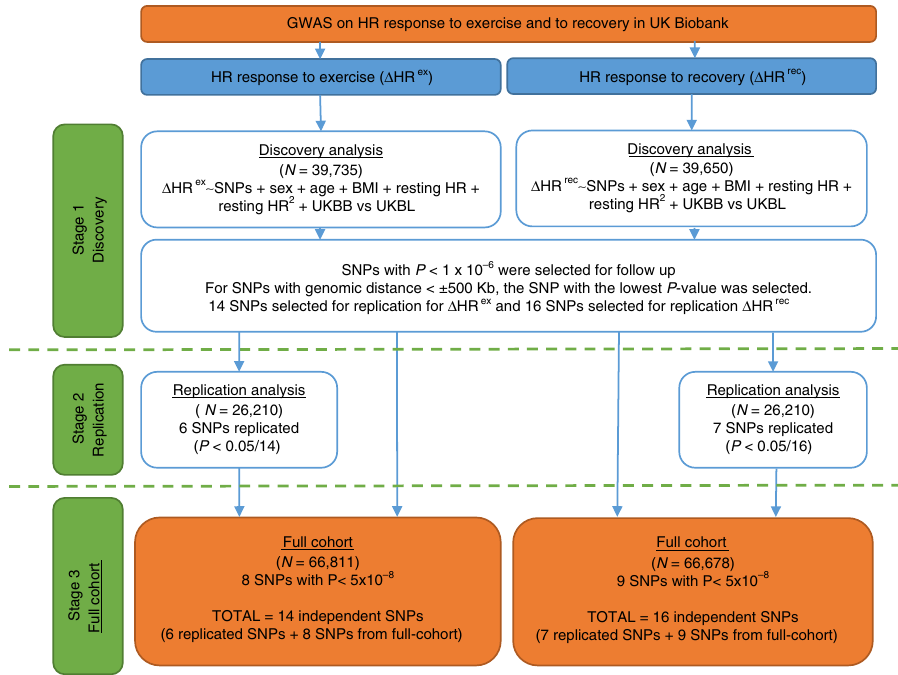
Fig. 1 Flowchart of the analytical 3-stage approach. HR heart rate, Δ HR ex changes in HR during exercise, Δ HR rec changes in HR 1 min post-exercise, SNP: single-nucleotide polymorphism, BMI: body mass index, UKBB: UK Biobank genetic array, UKBL: UK BiLEVE genetic array, UKBB vs. UKBL: binary indicator variable for UK Biobank versus UK BiLEVE to adjust for the different genotyping chips, MAF: minor allele frequency, HWE: Hardy – Weinberg Equilibrium, INFO: parameter indicating the quality of imputation, HRC: Haplotype Reference